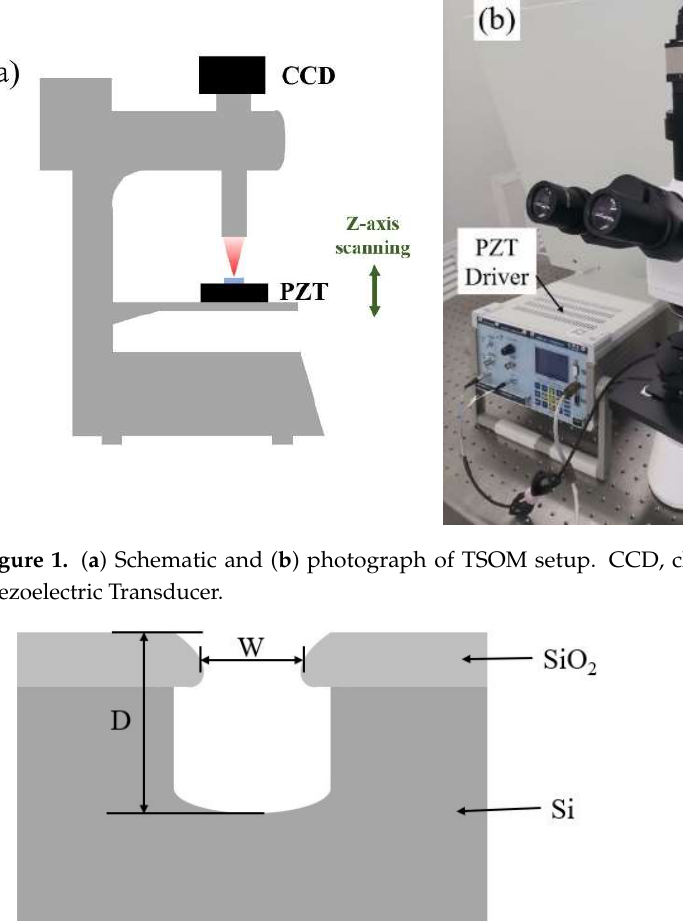
Figure 1. ( a ) Schematic and ( b ) photograph of TSOM setup. CCD, charge-coupled device; PZT, Pie- zoelectric Transducer.